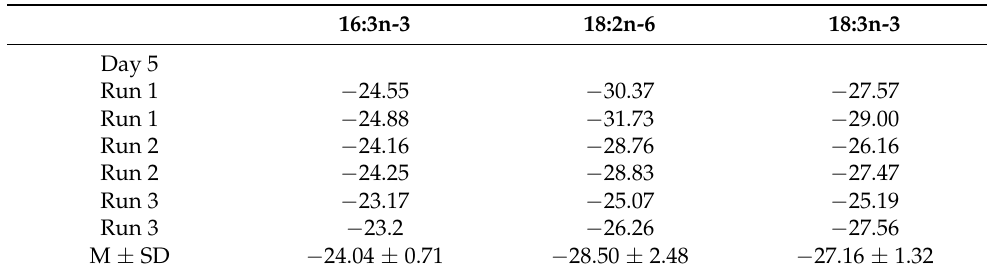
Table 2. Stable isotope composition of FAs selected for isotope mixing modelling in Daphnia galeata fed the mixture of algae: average values (M, ‰) ± standard deviation (SD).